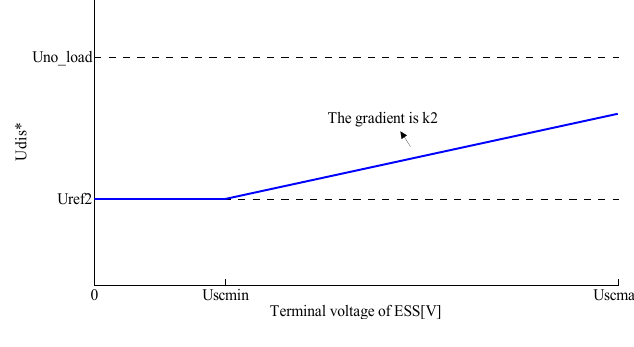
Figure 13. The values of U dis *